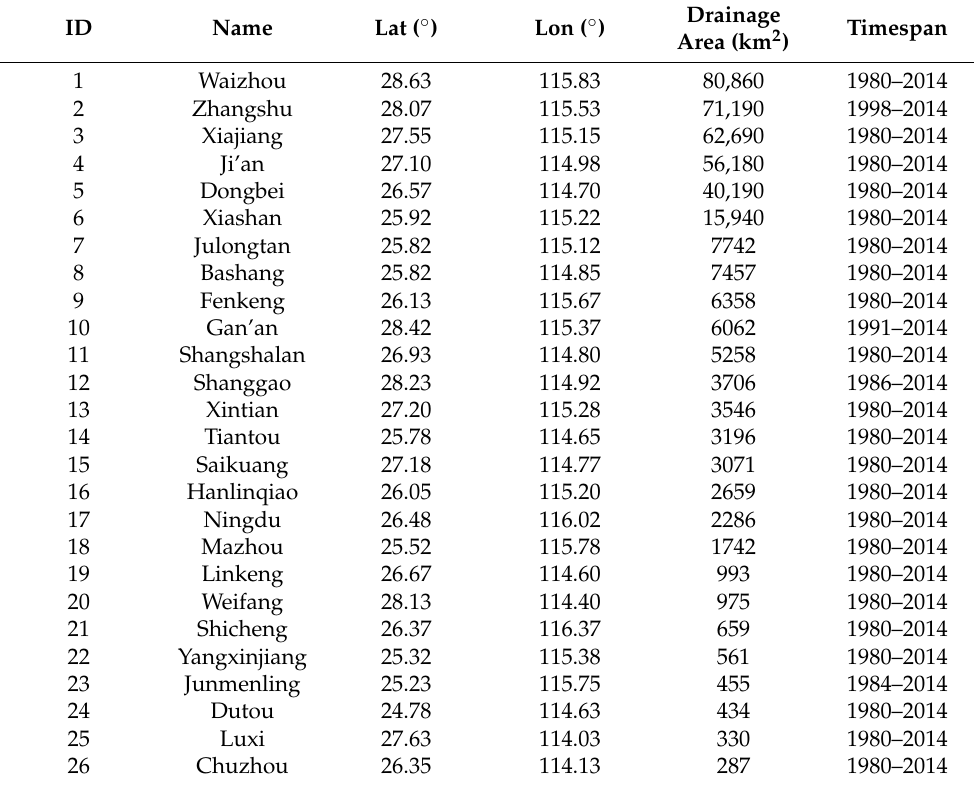
Table 1. Summary of 26 hydrological